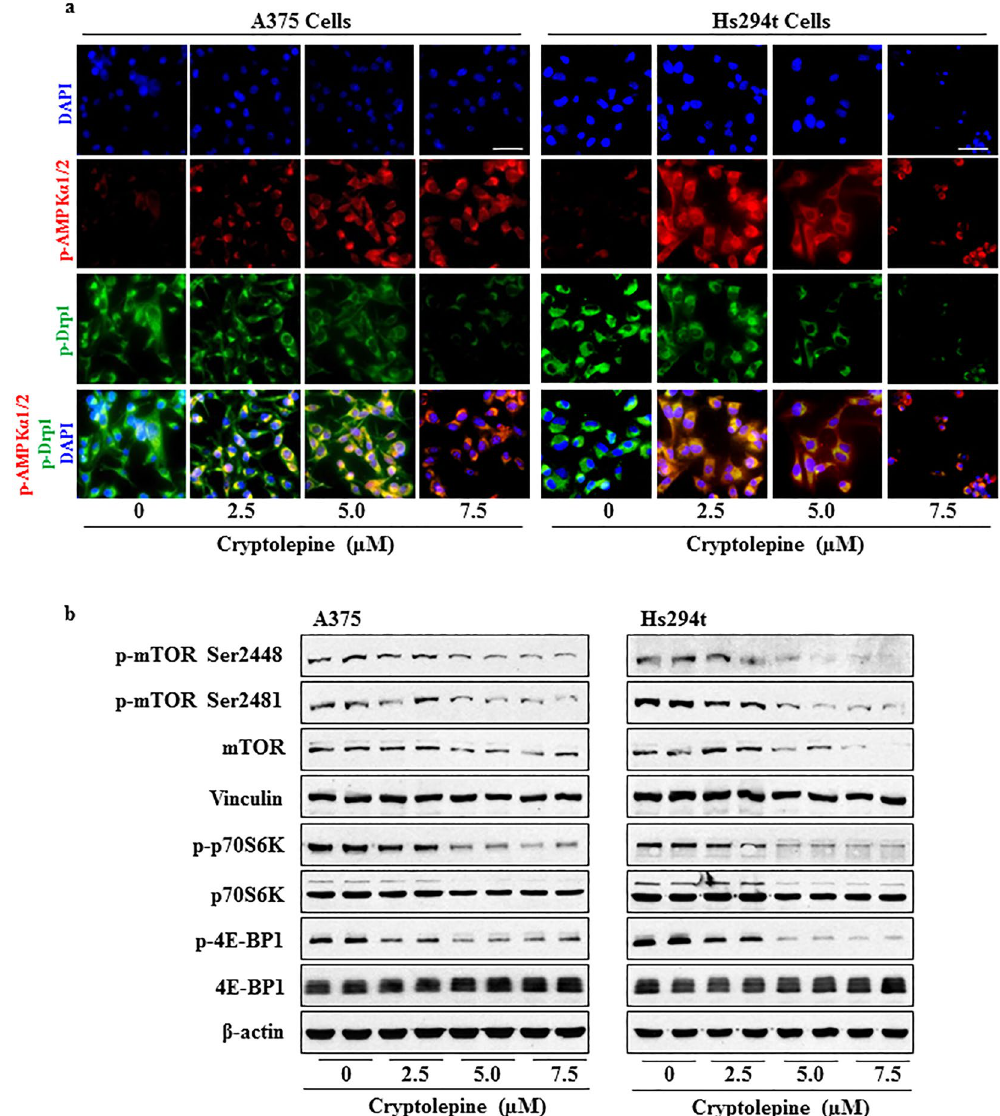
Figure 5. Treatment with cryptolepine disrupts mitochondrial dynamics by activating AMPK phosphorylation, reducing Drp1 phosphorylation and inhibiting mTOR signaling in melanoma cells. ( a ) Immunofluorescence staining of p-AMPK α 1/2 and p-Drp1 was performed after the treatment of cells with cryptolepine, as detailed in Materials and Methods. Photomicrographs were obtained using Keyence Fluorescence Microscope BZ-X710 (Keyence Corporation of America). A representative photomicrograph from each group is shown. ( b ) After treatment of A375 and Hs294t cells with cryptolepine for 24 h, total cell lysates were prepared and subjected to western blot analysis to determine the level of proteins involved in mTOR signaling. Blots were developed using a chemiluminescence-specific ECL system. Equal loading of proteins was verified by stripping the membrane and reprobing with anti- β -actin or vinculin